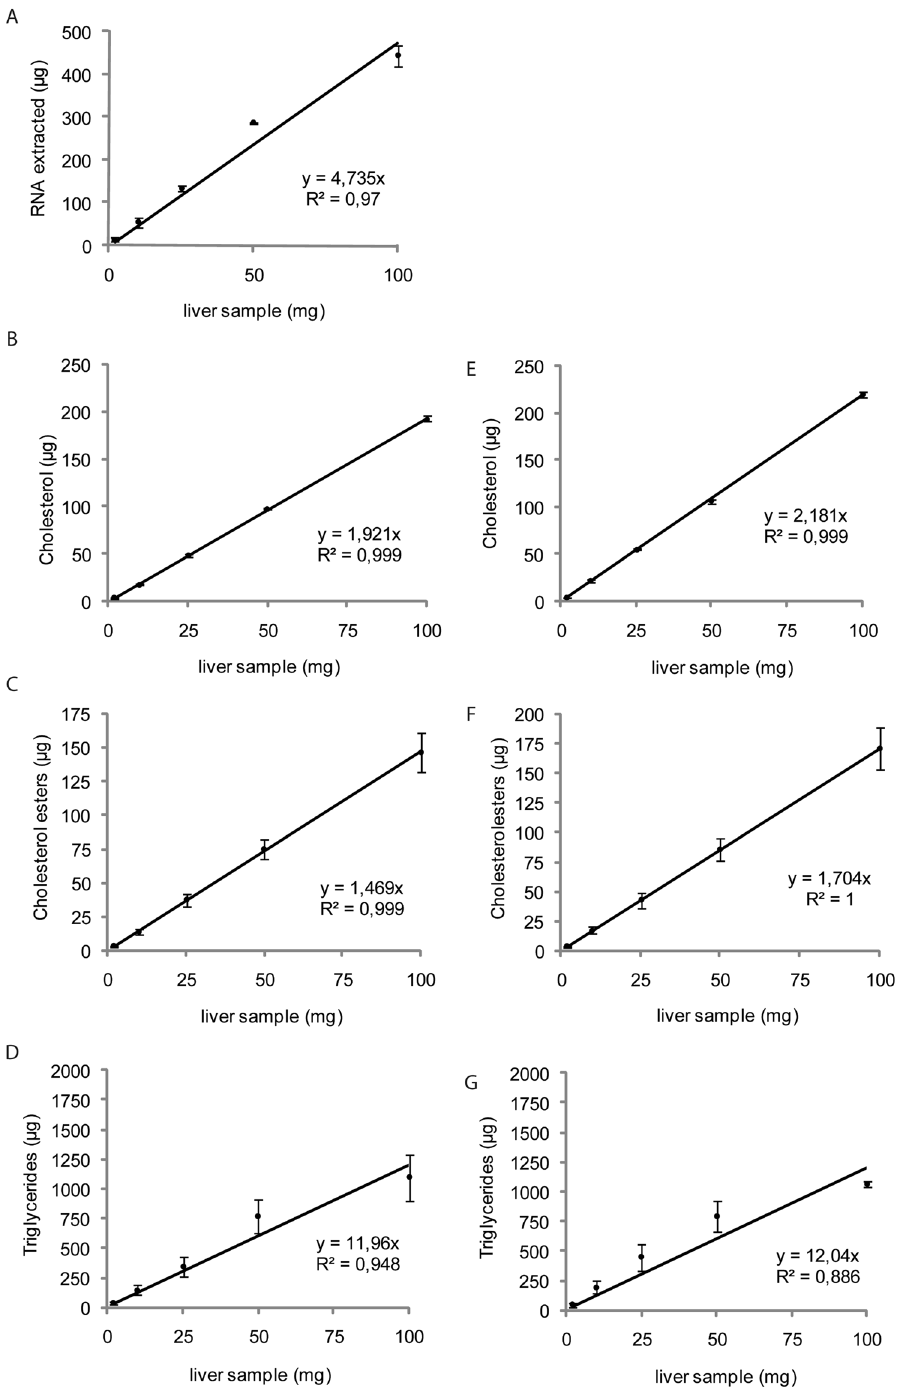
Figure 2. Trizol can be used to extract total lipids from mouse liver samples over a wide range of weights. ( A ) Commercially available Trizol was used to extract mRNA and ( B ) cholesterol, ( C ) cholesterol esters, and ( D ) triglycerides from mouse liver samples of 1 to 100 mg. ( E ) Bligh & Dyer was also used for cholesterol, ( F ) cholesterol ester, and ( G ) triglyceride extraction from mouse liver samples of 1 to 100 mg. RNAs were analyzed by qPCR and lipids by gas chromatography. Data are presented as means ± s.e.m. (n = 4 samples per